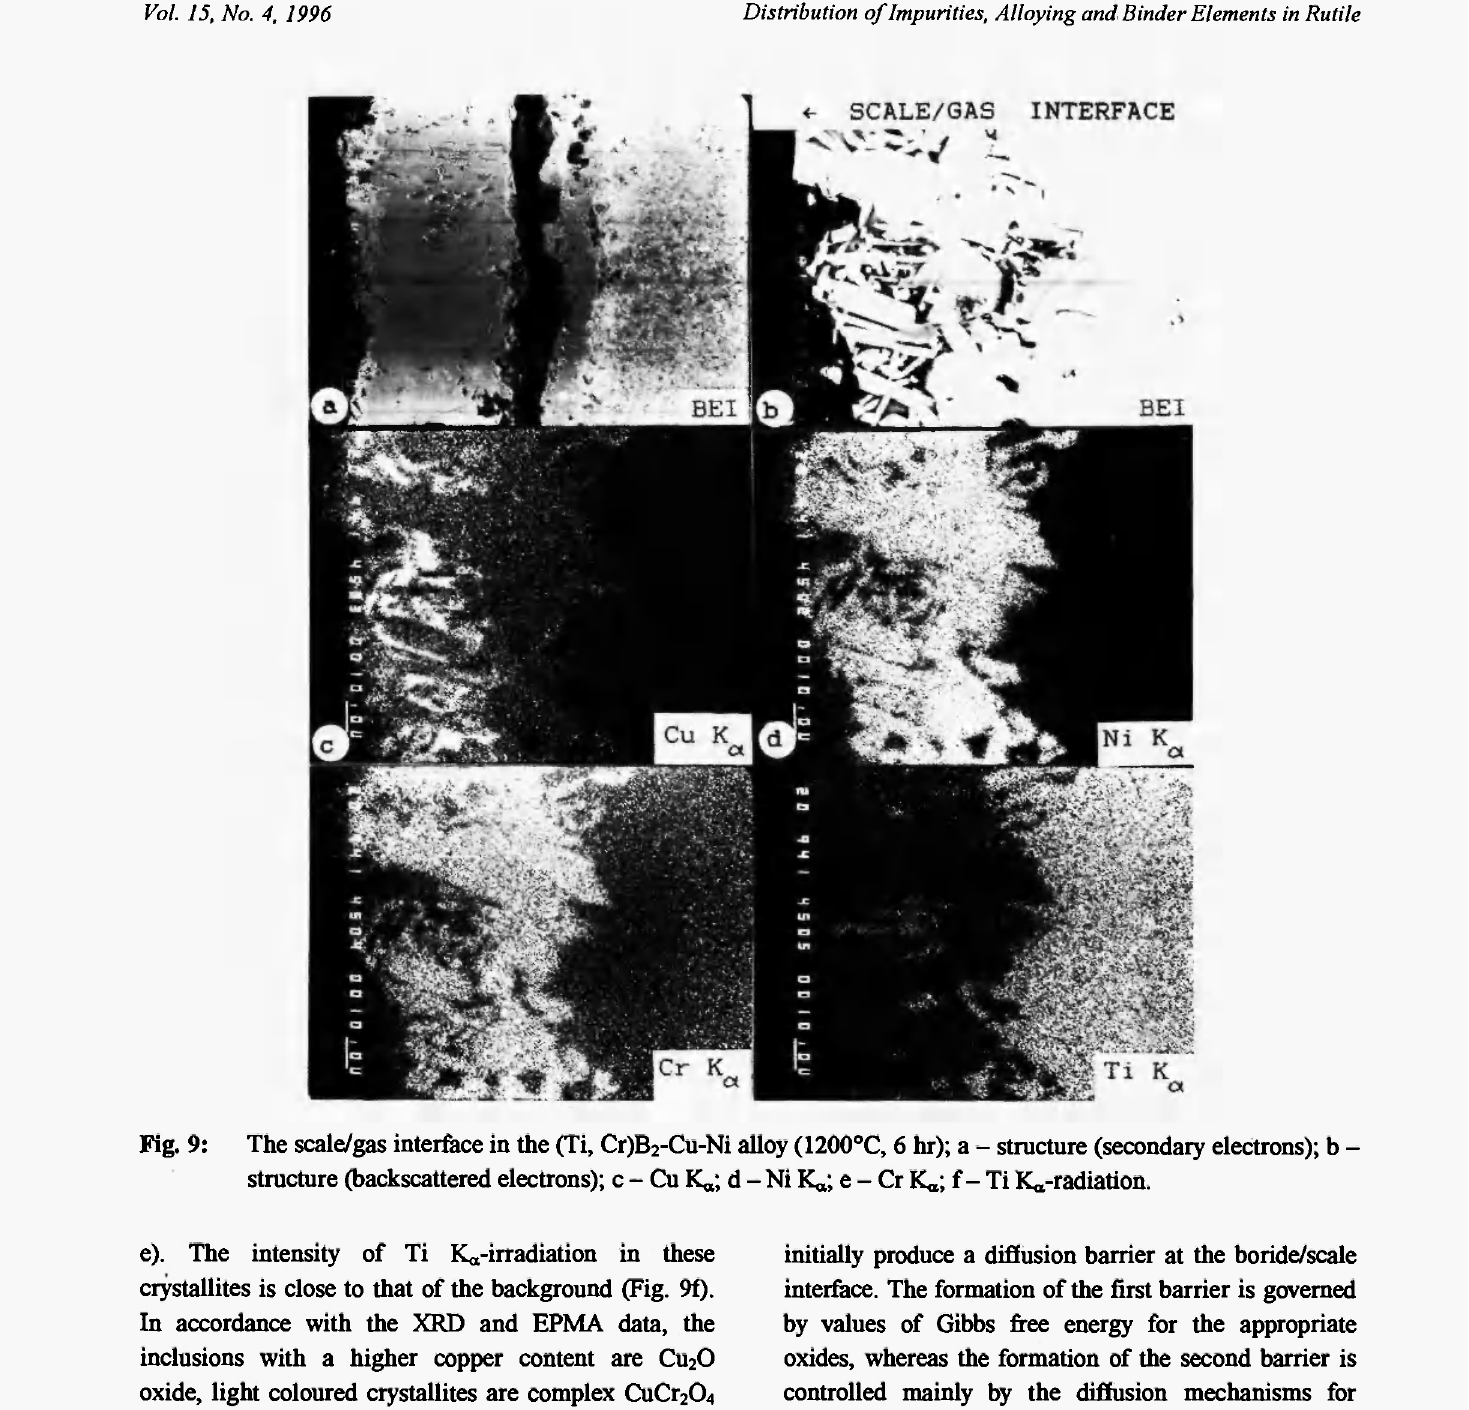
Fig. 9: The scale/gas interface in the (Ti, Cr)B -Cu-Ni alloy (1200°C, 6 hr); a - structure (secondary electrons); b - 2 structure (backscattered electrons); c - Cu K«; d - Ni K«; e - Cr K^; f- Ti K^-radiation. e). The intensity of Ti Κα-irradiation in these crystallites is close to that of the background (Fig.